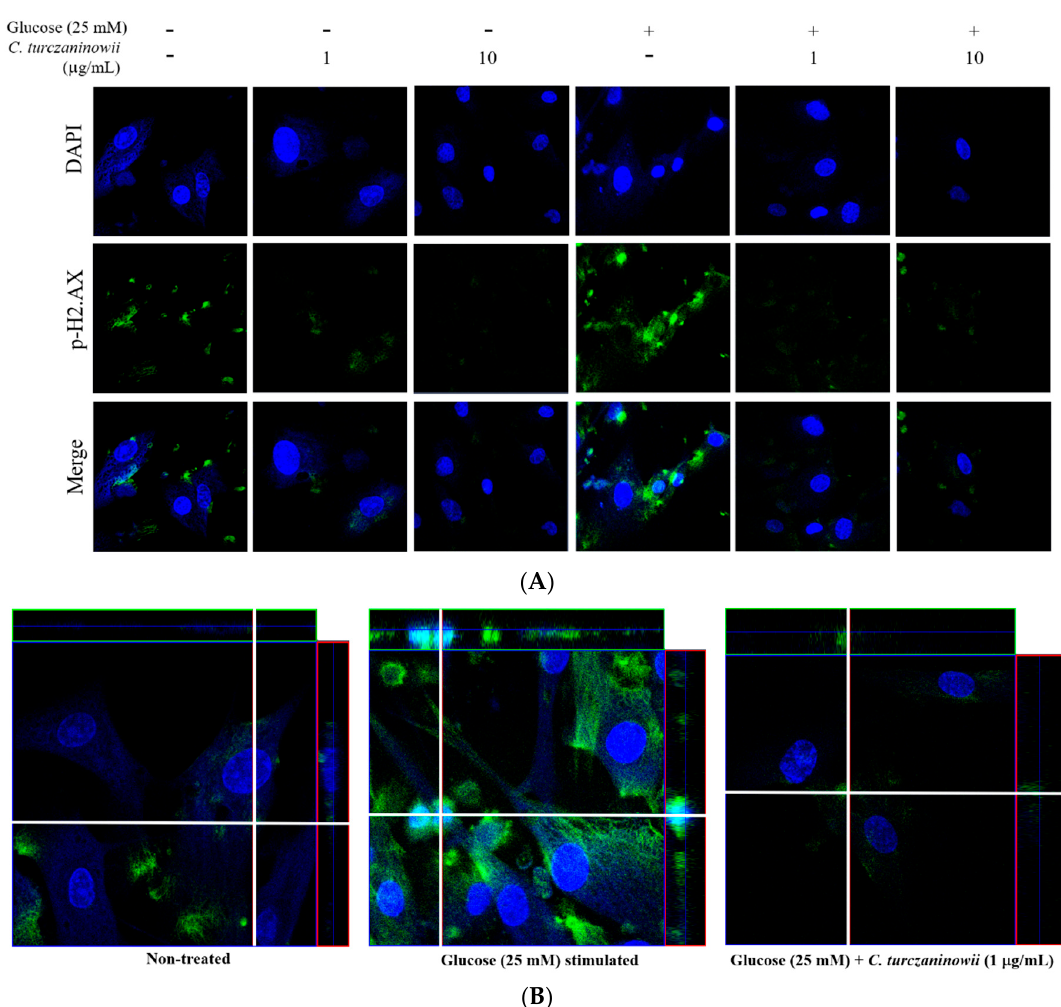
Figure 1. C. turczaninowii extract suppresses the mRNA expression of inflammatory cytokines and an endoplasmic reticulum (ER) stress marker in hASMCs under high glucose conditions in vitro. Data are expressed as mean ± SD. * p < 0.05 relative to with non-treated cells, and φ p < 0.05 compared with glucose-stimulated cells. The mRNA levels of TNF- α ( a ), IL-6 ( b ), and CHOP ( c ) were measured by reverse transcription PCR. Three wells were used in each condition per experiment, and all the experiments were repeated three times. C. turczaninowii : Carpinus turczaninowii ; CHOP: CCAAT-enhancer-binding proteins homologous protein; hASMCs: human aortic vascular smooth muscle cells; IL-6: interleukin-6; TNF- α : tumor necrosis factor- α .